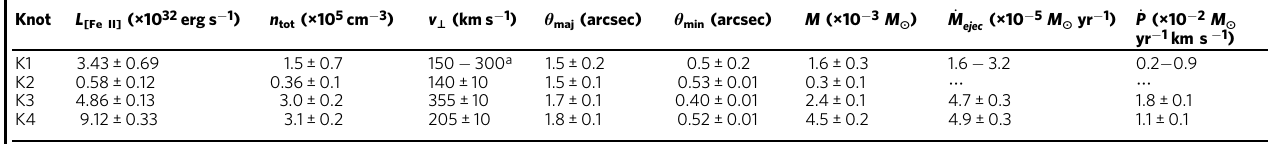
The source of uncertainties in Columns 4 – 6 is coming from measurement uncertainties, whereas in Columns 2, 3, 7 – 9 comes from performing the error propagation in the speci fi c equations a Assuming a tangential velocity of 150 – 300kms − 1 from the proper motions of ref. 22 .